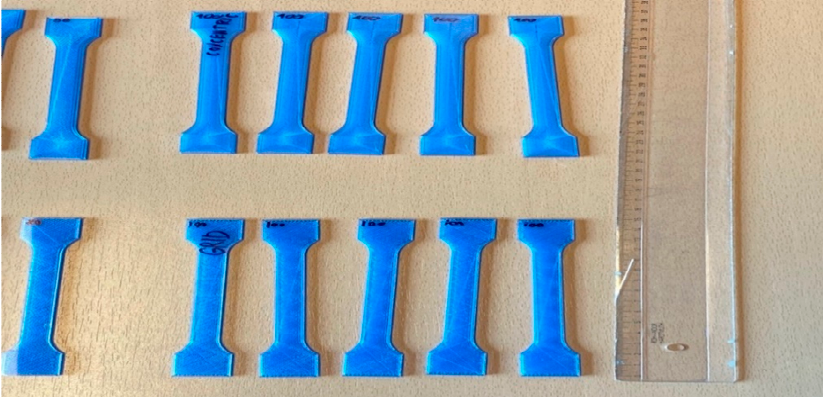
Figure 2. Testing materials standard for the specimens.